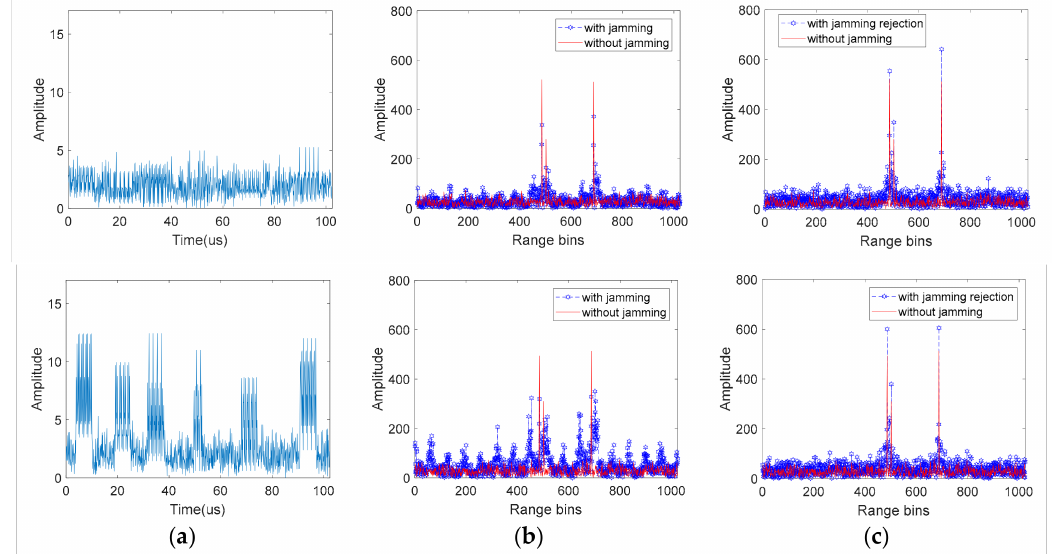
Figure 2. The waveform of the received signal and the range compression results with di ff erent jamming-to-signal power ratio. ( a ) Amplitude of the received signal with jamming; ( b ) range compression result of the received signal with jamming; ( c ) range compression result of the received jamming rejected signal. (From top to bottom, the jamming-to-signal power ratio are 0dB and 10dB